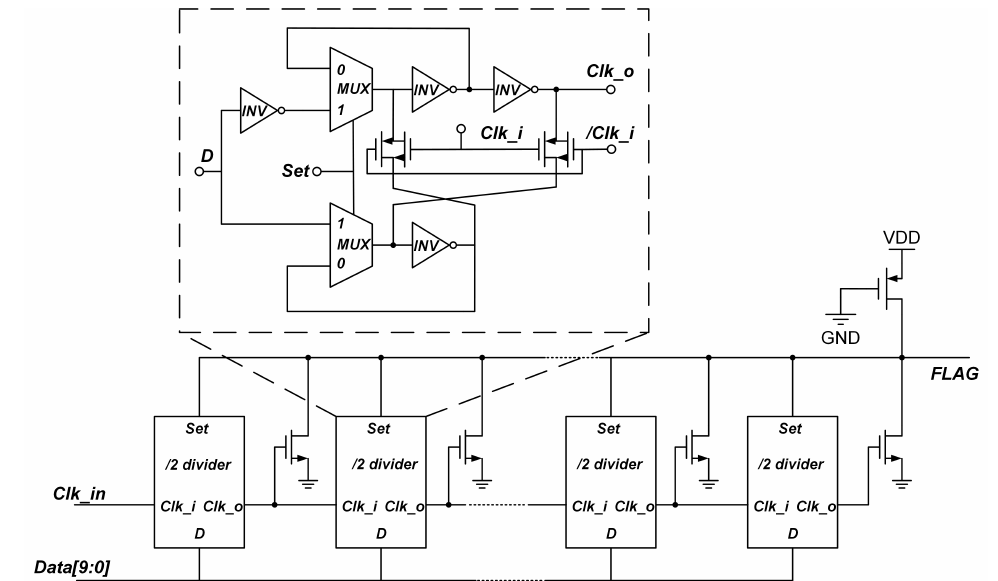
Figure 5. The structure of the multi-modulus